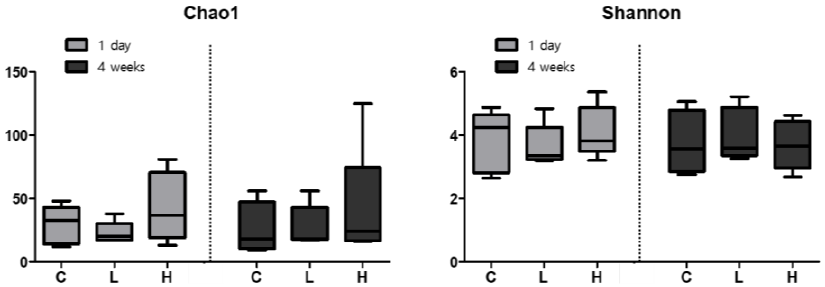
Figure 4. Biochemical analysis of bronchoalveolar lavage fluid (BALF) after intratracheal instillation of nickel oxide nanoparticles (NiO NPs). Lactate dehydrogenase (LDH) levels, total protein levels, turbidity, and phospholipid levels are indicated. Turbidity was measured as optical density at 600 nm. LDH, total protein, phospholipids, and turbidity level in the BALF significantly increased at 4 weeks after instillation. Data are presented as mean ± standard deviation (SD). One-way analysis of variance (ANOVA) was performed for the comparison between the NiO NPs-treated and control groups with statistical significance indicated by * p < 0.05 and *** p < 0.001. C: control group; L: low-dose group (50 cm 2 /rat); H: high-dose group (150 cm 2 /rat).